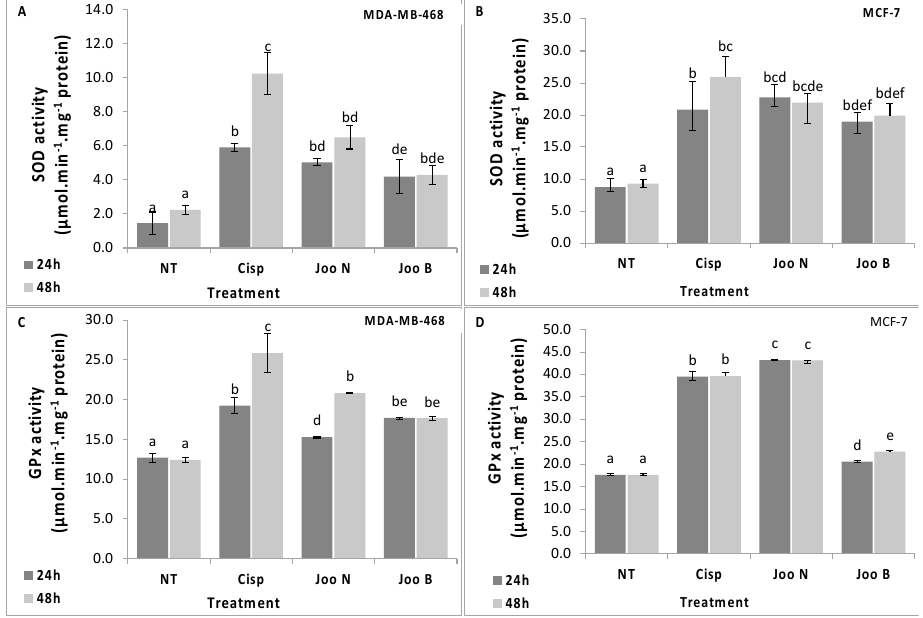
Figure 3. Activities of antioxidative enzymes; superoxide dismutase (SOD, A and B ) and glutathione peroxidase (GPx, C and D ) in the MDA-MB-468 ( A and C ) and MCF-7 ( B and D ) cell lines after treatment with methanolic extracts of Joo needles ( Joo N) and Joo berries ( Joo B). Each value represents the mean of six replicates. Bars represent the standard error. Different letters indicate significant differences among treatments at p = 0.05.